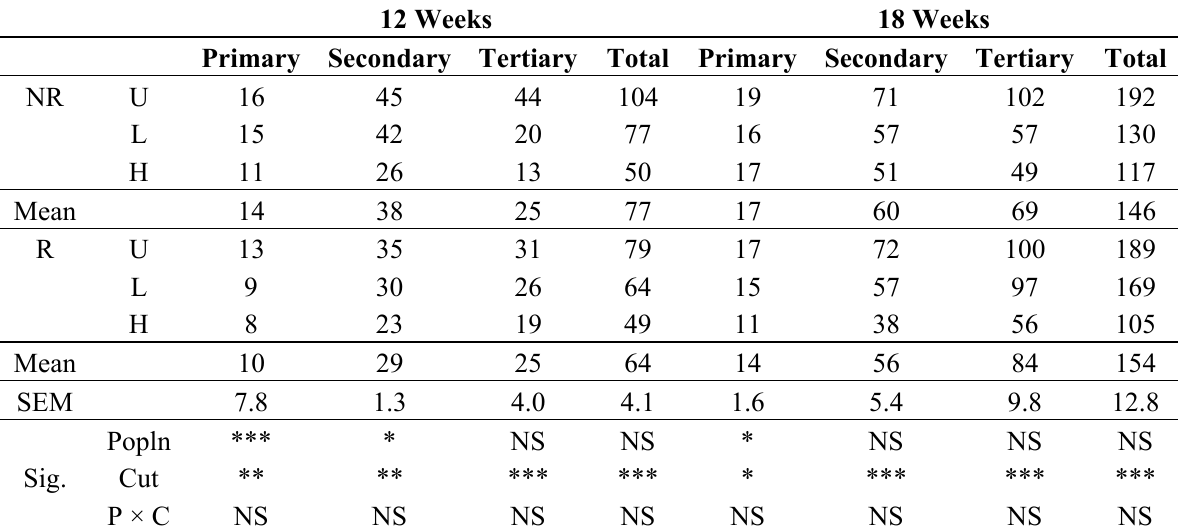
Table 2. Tiller numbers per plant, categorized by position on the tiller axis, on non-rhizomatous (NR) and rhizomatous (R) populations undefoliated (U), or under lax (L) or hard (H) defoliation after a 12 or 18 week growing